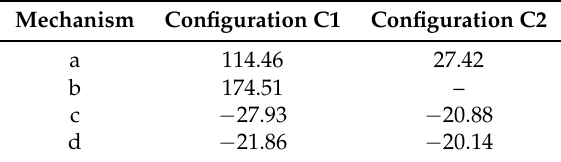
Quantum-mechanics/molecular-mechanics (QM/MM) reaction energies (kcal/mol) corresponding to Scheme